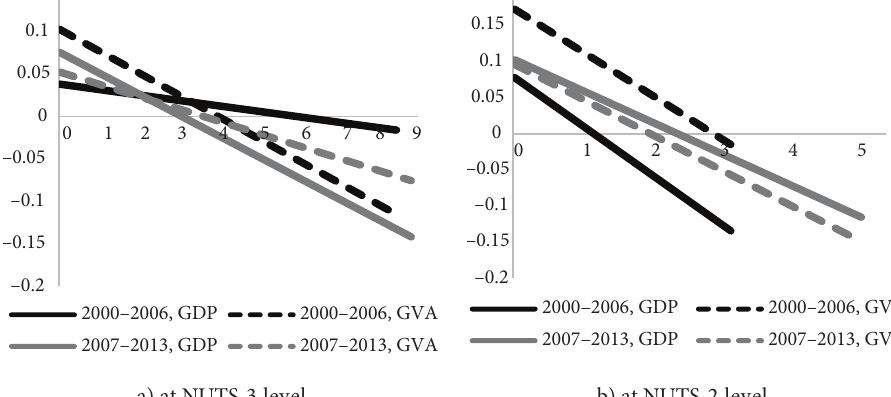
level 2 STUN ta )b level 3 STUN ta